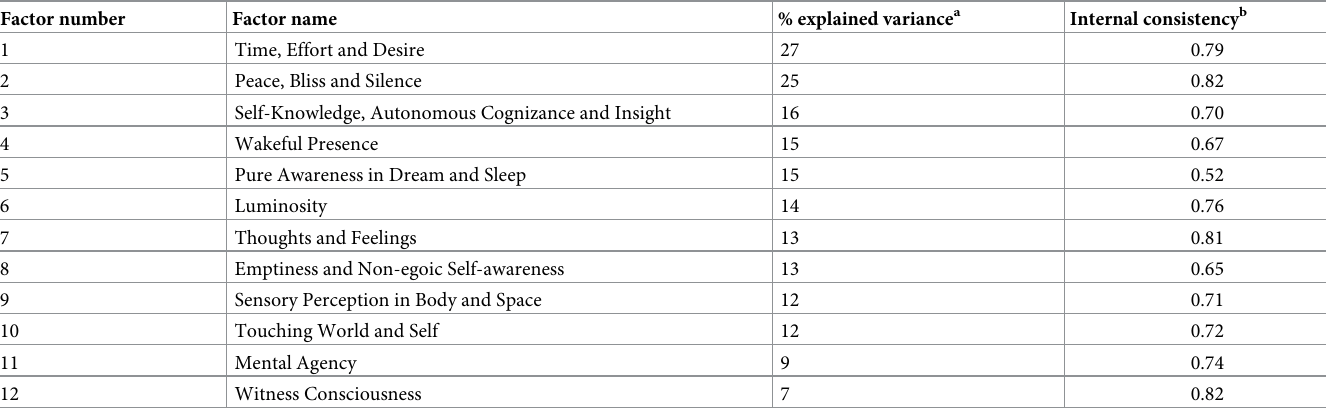
Table 5. Factor names and explained variance per